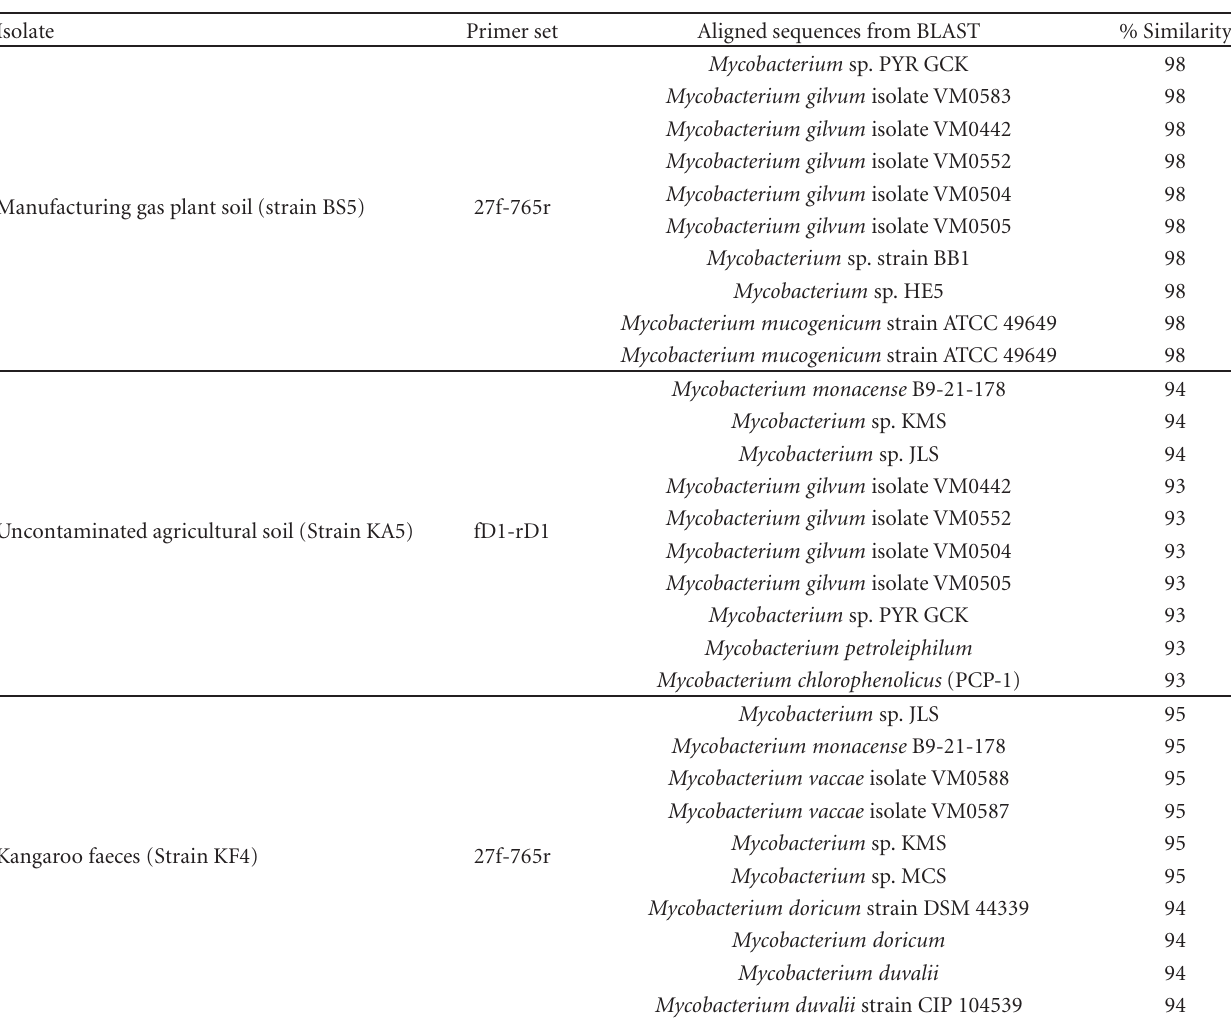
Table 2: 16S rRNA identification of PAH-degrading bacterial isolates from enrichment cultures containing manufacturing gas plant soil, uncontaminated agricultural soil, and kangaroo faeces. The top ten aligned sequences between bacterial isolates and members of the BLAST sequence database are